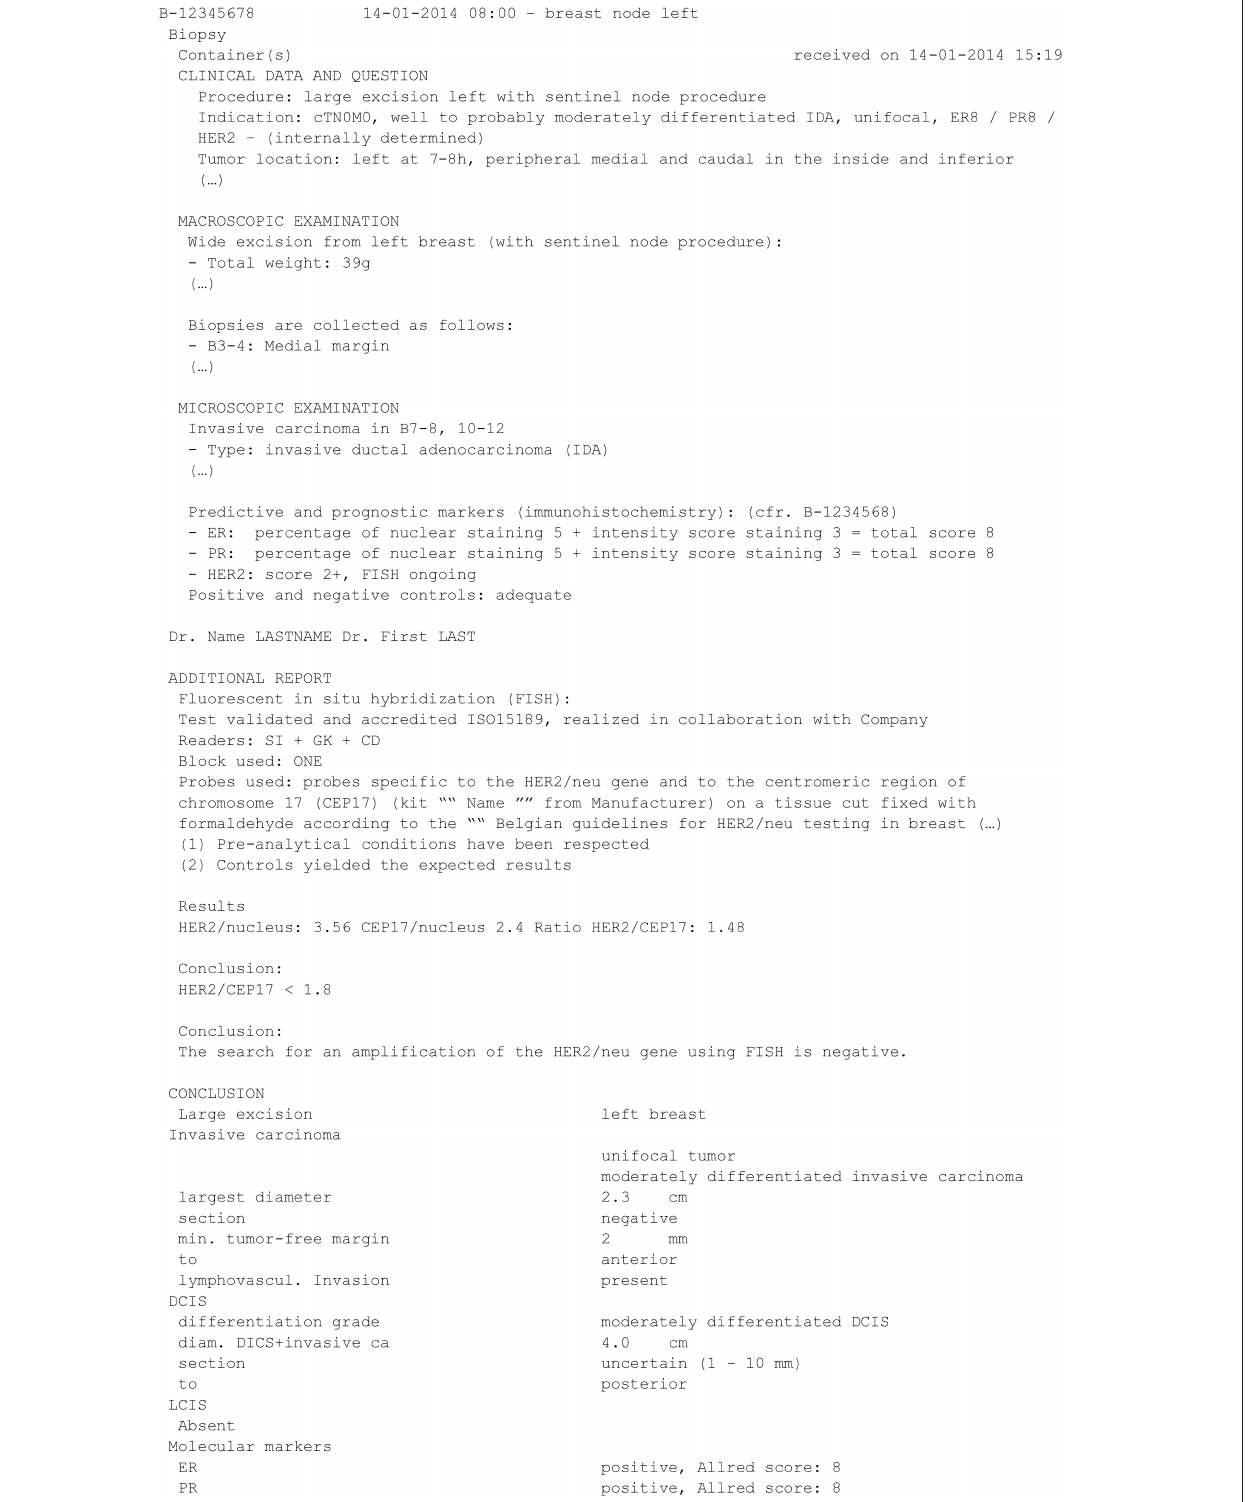
FIGURE 1 | Fictive example of a breast cancer pathology report (translated into English). This report (shortened to only contain the text relevant to the present work) presents results about the status of three biomarkers of interest: ER, PR, and HER2. The status of HER2 can be assessed using immunohistochemistry (IHC) and/or in-situ hybridization